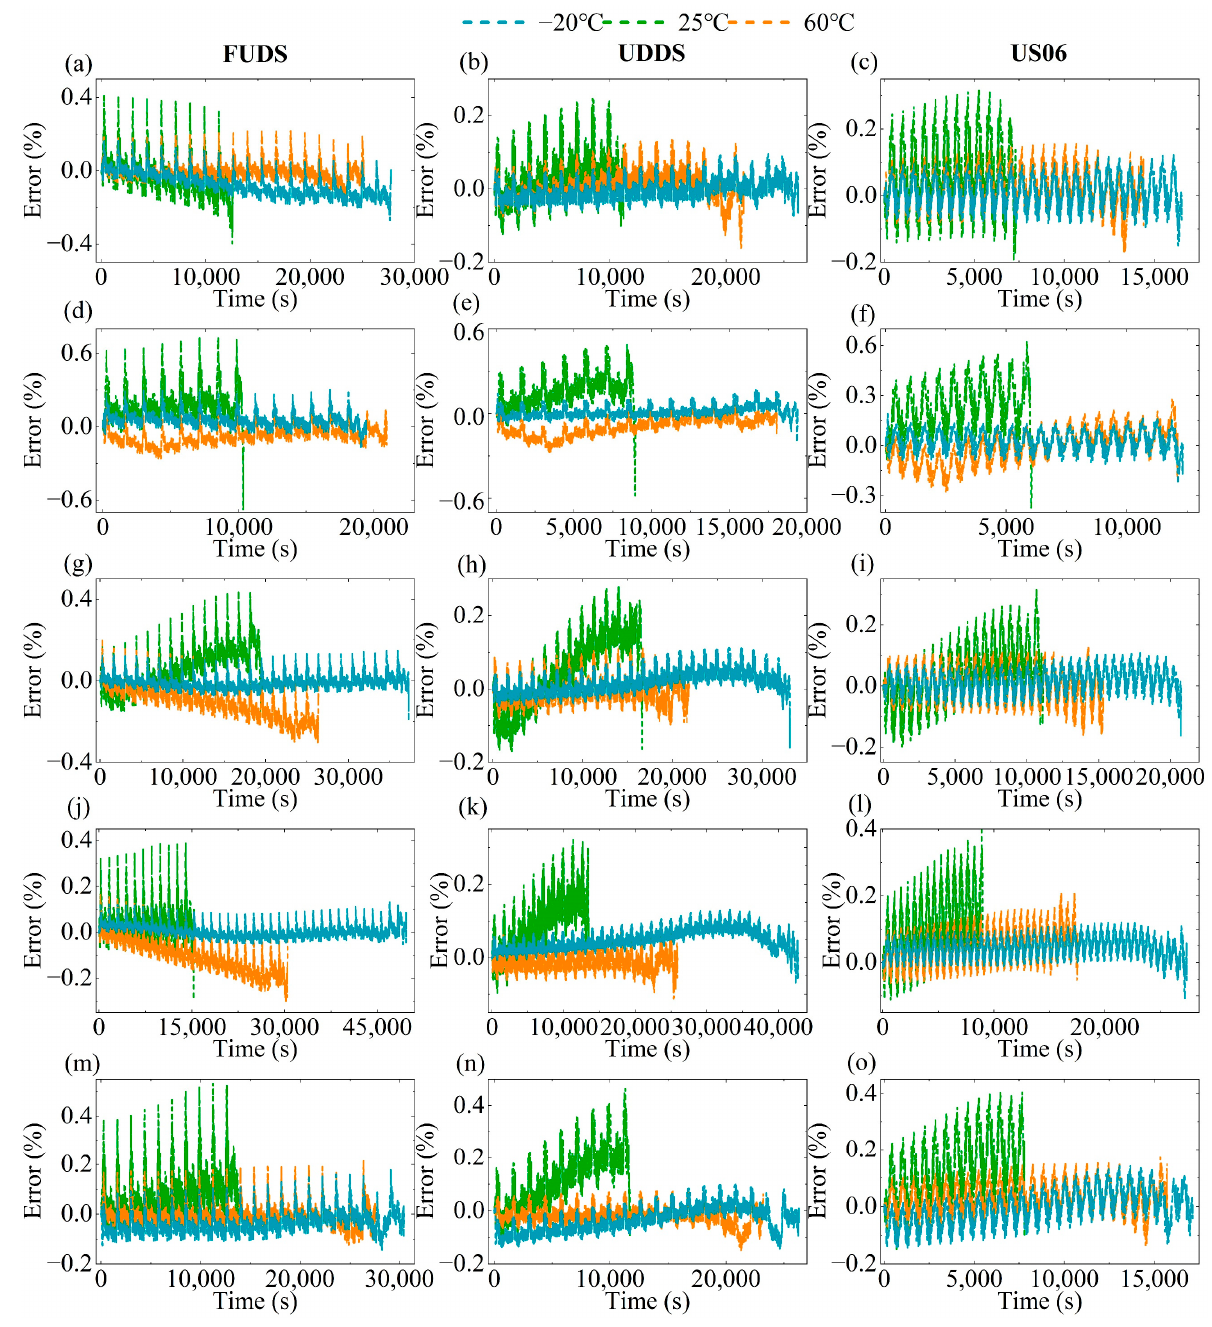
Figure 9. The estimation errors of ATCN-v2 model for different types of batteries under different conditions and temperatures: ( a – c ) LR1865SZ; ( d – f ) LR1865EH; ( g – i ) LR1865SK; ( j – l ) ICR18650; ( m – o ) LR2170SA.